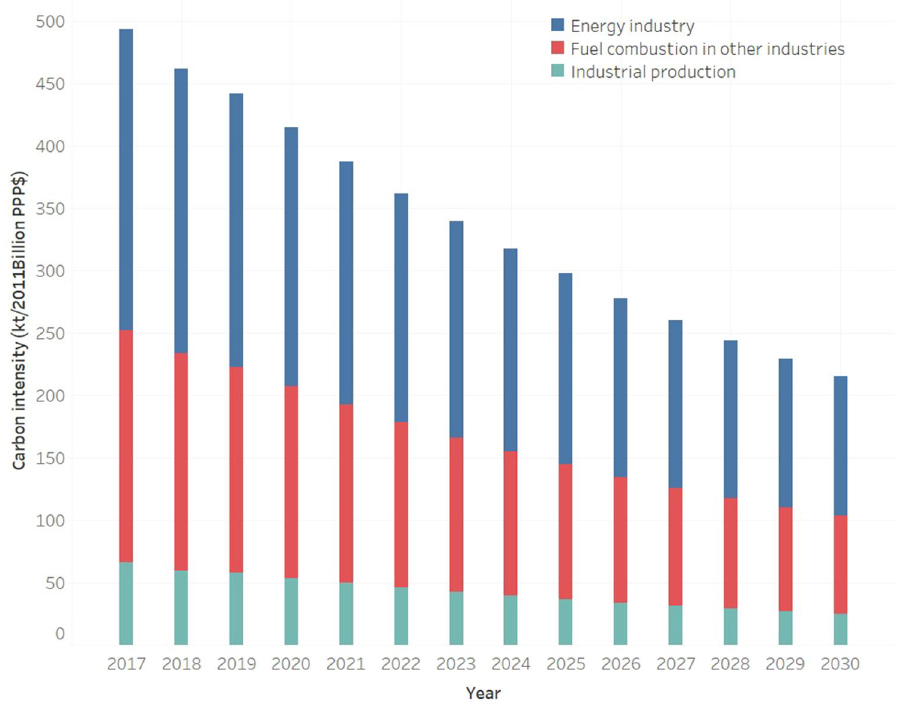
Figure 4. CO 2 emission intensity forecast from 2018 to 2030. (Data Source: prediction